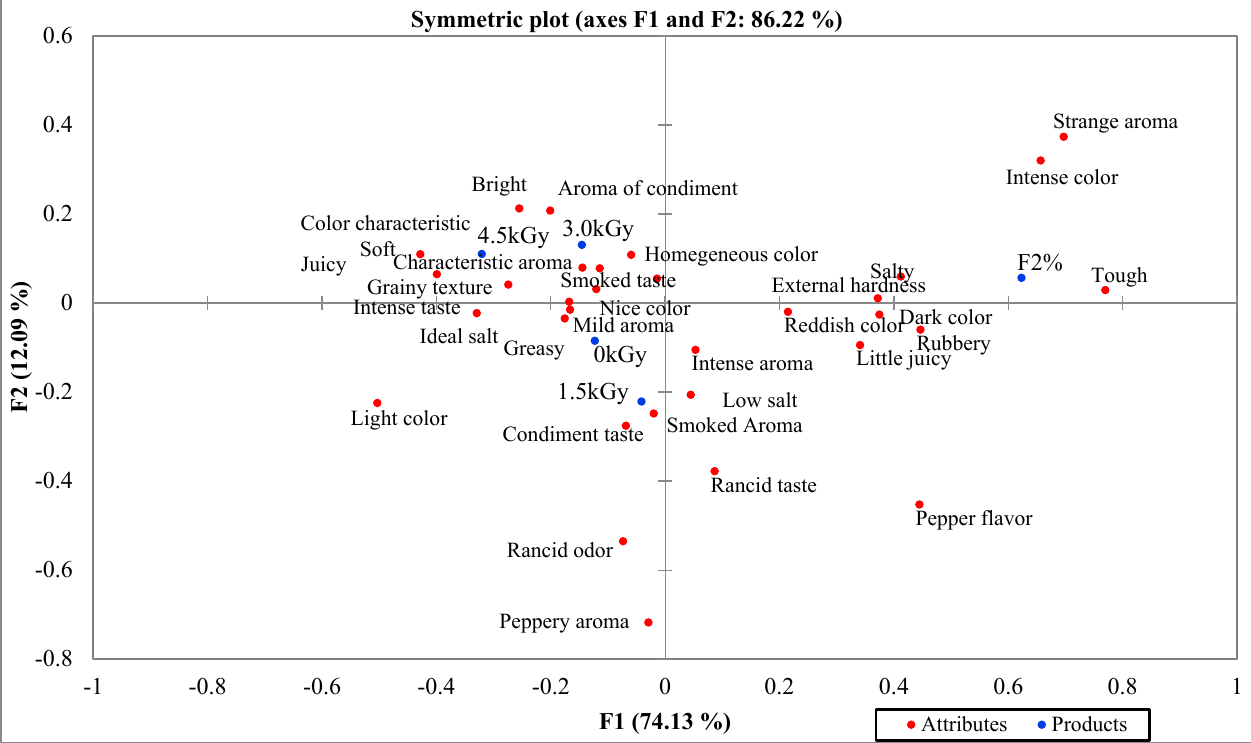
Figure 1. Graphic distribution of sodium-reduced and irradiated hot dog in relation to sensory attributes perceived by consumers in the CATA questionnaire. F2%—A (without sodium reduction and without irradiation. F0 kGy—B (with sodium reduction and without irradiation) (F0). F4.5 kGy—C (with sodium reduction and irradiated with the highest dose).